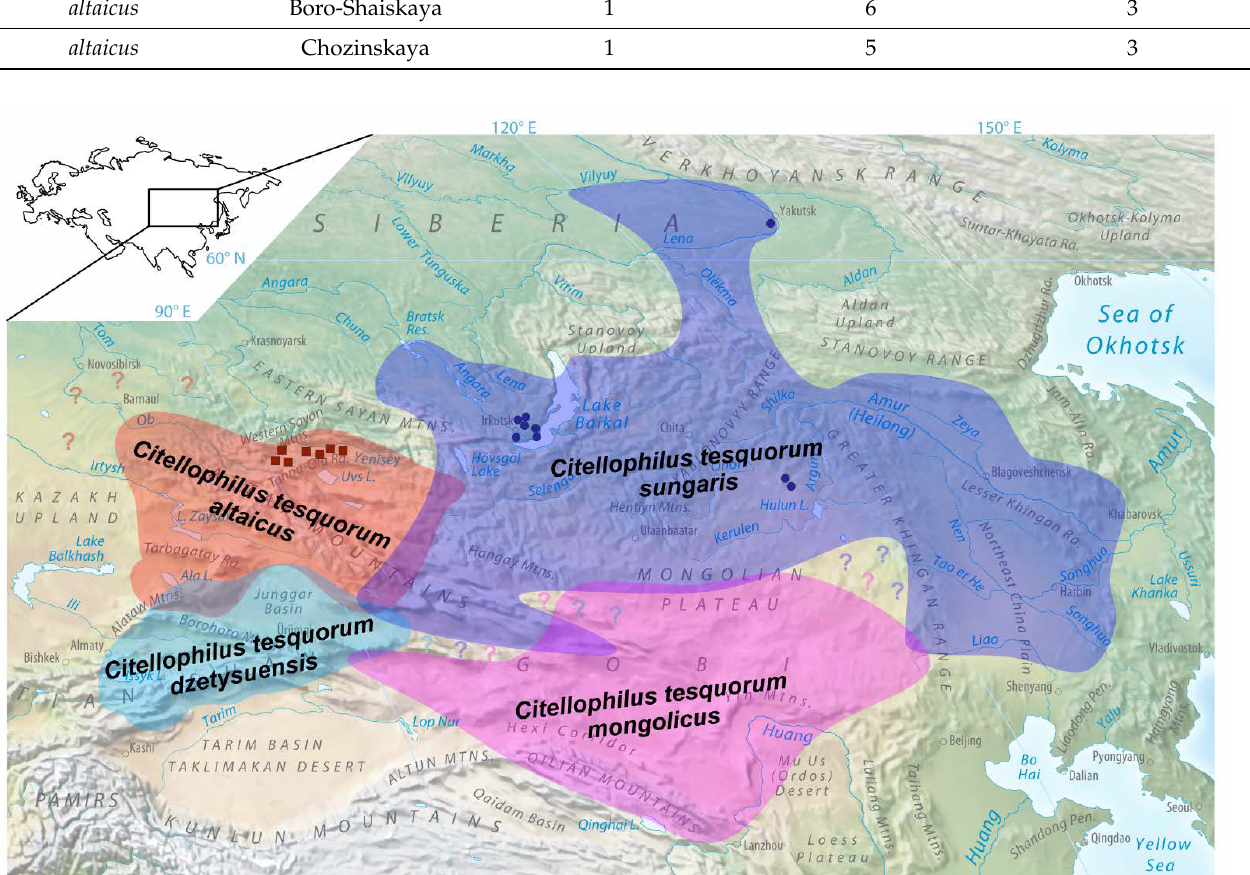
Figure 1. Ranges of four Citellophilus tesquorum subspecies. The map based on Tan, Shen [13], and Verzhutsky et al. [19]. Table 2. Morphological delimitation traits of four Citellophilus tesquorum subspecies.